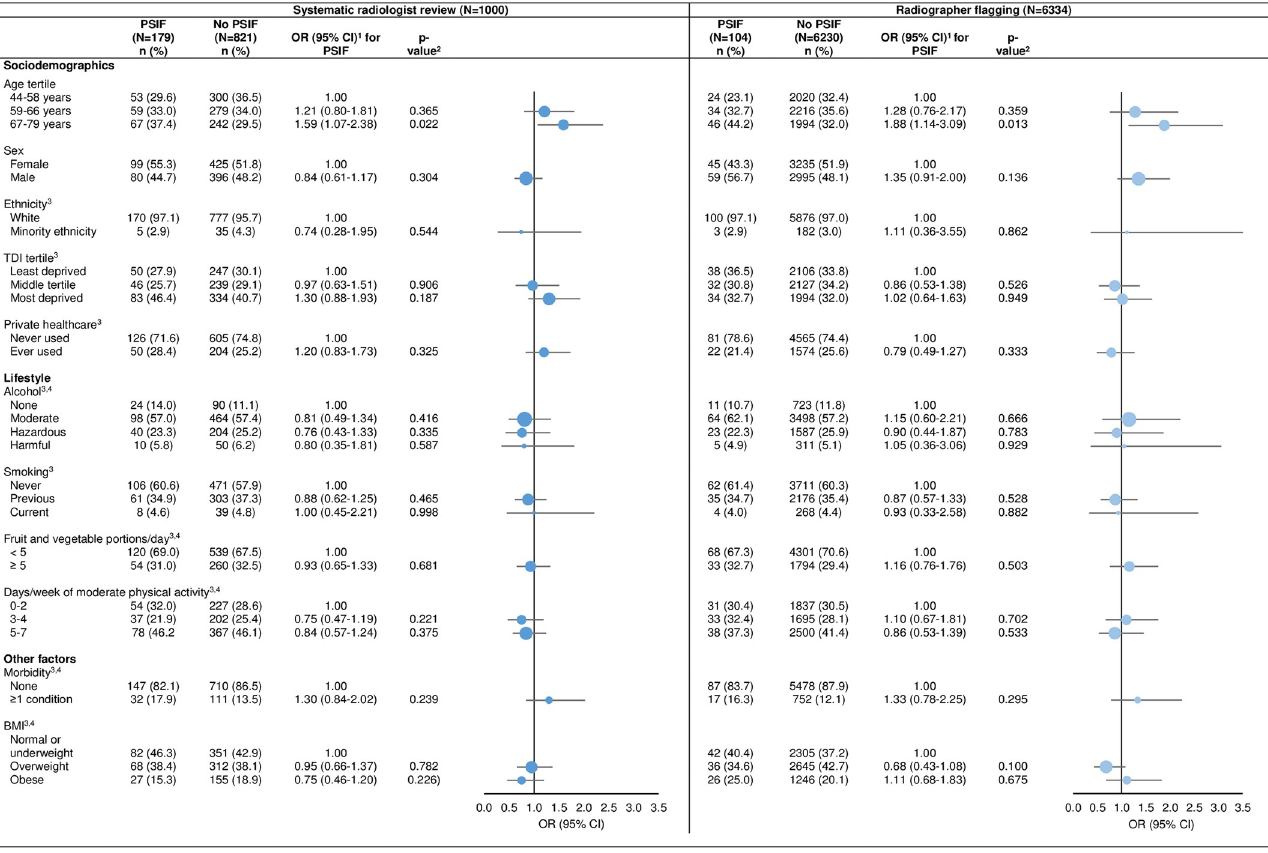
Fig 2. Age- and sex-adjusted odds ratios for potentially serious incidental findings (PSIFs) stratified by PSIFs protocol. PSIFs = potentially serious incidental findings, OR = odds ratio, CI = confidence interval, TDI = Townsend Deprivation Index, BMI = body mass index. Circles are weighted by the proportion of participants within a category. 1. Age- and sex-adjusted ORs, except age tertiles which are adjusted for sex only, and sex which is adjusted for age only. 2. p-value from Wald test. 3. Data were missing for ethnicity (13/1000 [1.3%], 73/6334 [1.2%]), TDI (1/1000 [0.1%], 3/6334 [ < 0.0%]), private healthcare use (15/1000 [1.5%], 92/6334 [1.5%]), alcohol (20/1000 [2.0%], 112/6334 [1.8%]), smoking (12/1000 [1.2%], 78/6334 [1.2%]), fruit and vegetable intake (27/1000 [2.7%], 138/6334 [2.2%]), physical activity (35/1000 [3.5%], 200/6334 [3.2%]) and BMI (5/1000 [0.5%], 34/6334 [0.5%]), for participants assessed by systematic radiologist review and by radiographer flagging respectively. 4. We calculated alcohol intake, fruit and vegetable intake, physical activity, morbidity and BMI as described in the footnotes to Table